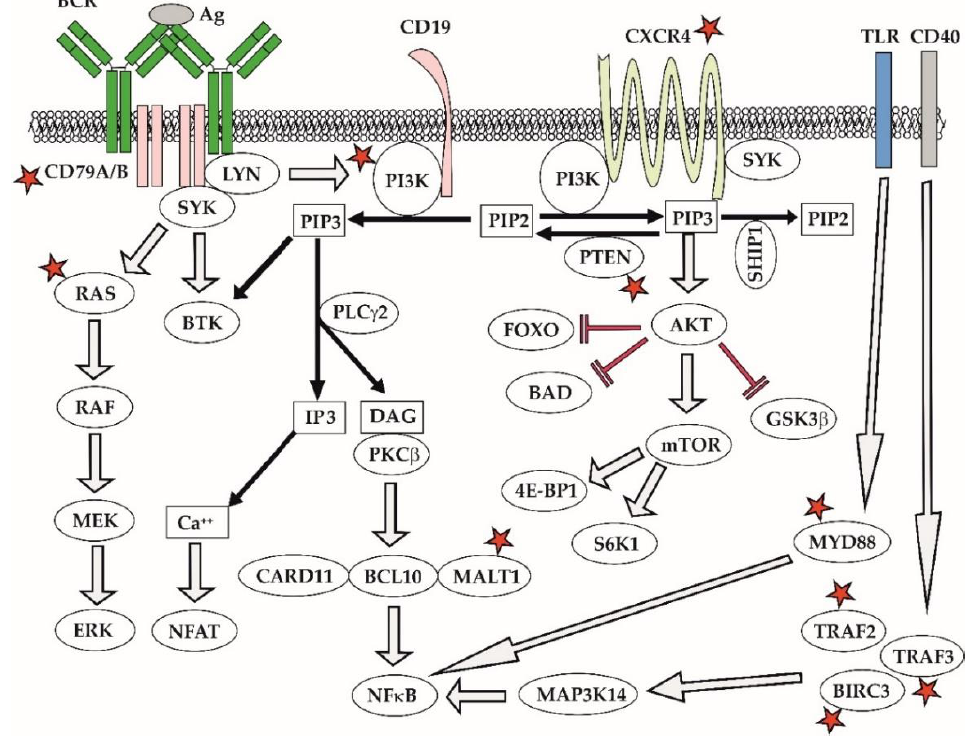
Figure 7. B cell receptor and PI3K signaling . Abbreviations: AKT—protein kinase B/AKT, BCL10— B cell lymphoma 10, BCR—B-cell receptor signaling, BIRC3—Baculoviral IAP (inhibitor of